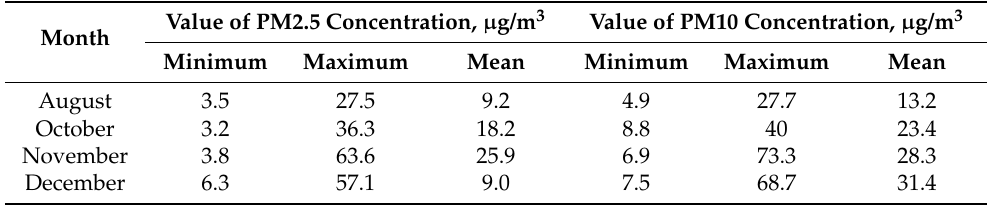
Table 3. The statistics for the PM concentration values ( µ g/m 3 ) for the months August–December 2021 at the air monitoring station [59].